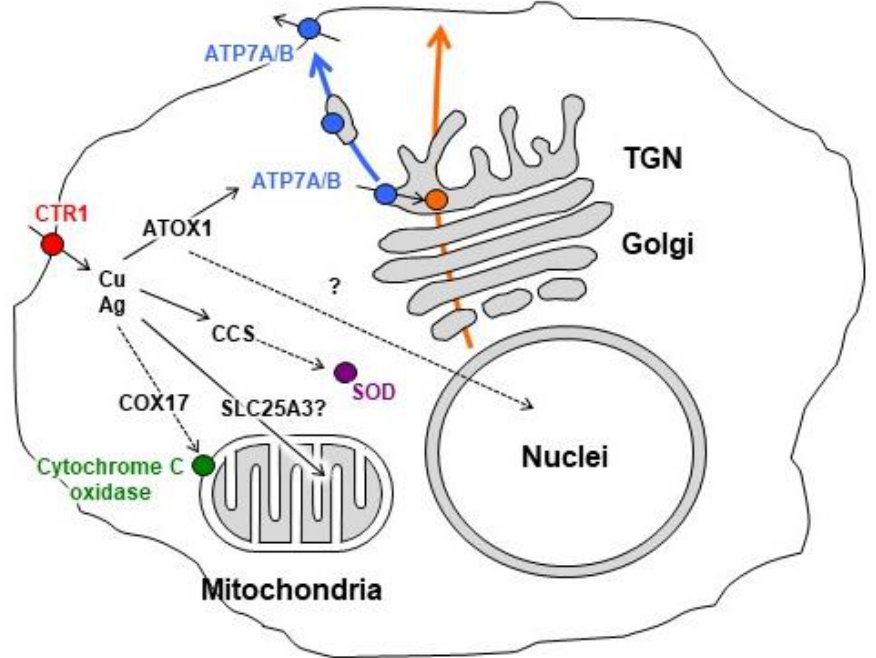
Figure 2. Scheme of copper distribution in a mammalian cell. Bulk copper is taken up via CTR1. After being imported into the cell, the copper is transferred to copper chaperones for SOD1 (CCS), copper chaperones for cytochrome-c-oxidase (COX17), and copper chaperones for copper-transporting ATPases (ATP7A/B) antioxidant protein 1 (ATOX1). In turn, ATP7A/B transmits copper into the Golgi lumen. In the Golgi, ATP7A/B loads copper on newly synthesized cuproenzymes, which transport it along the biosynthetic pathway. In the cells, the Cu(I)/Cu(II) redox cycle including metallothionein Cu(I), glutathione Cu(I)/Cu(II), and COMMD1 (CuII) exists.